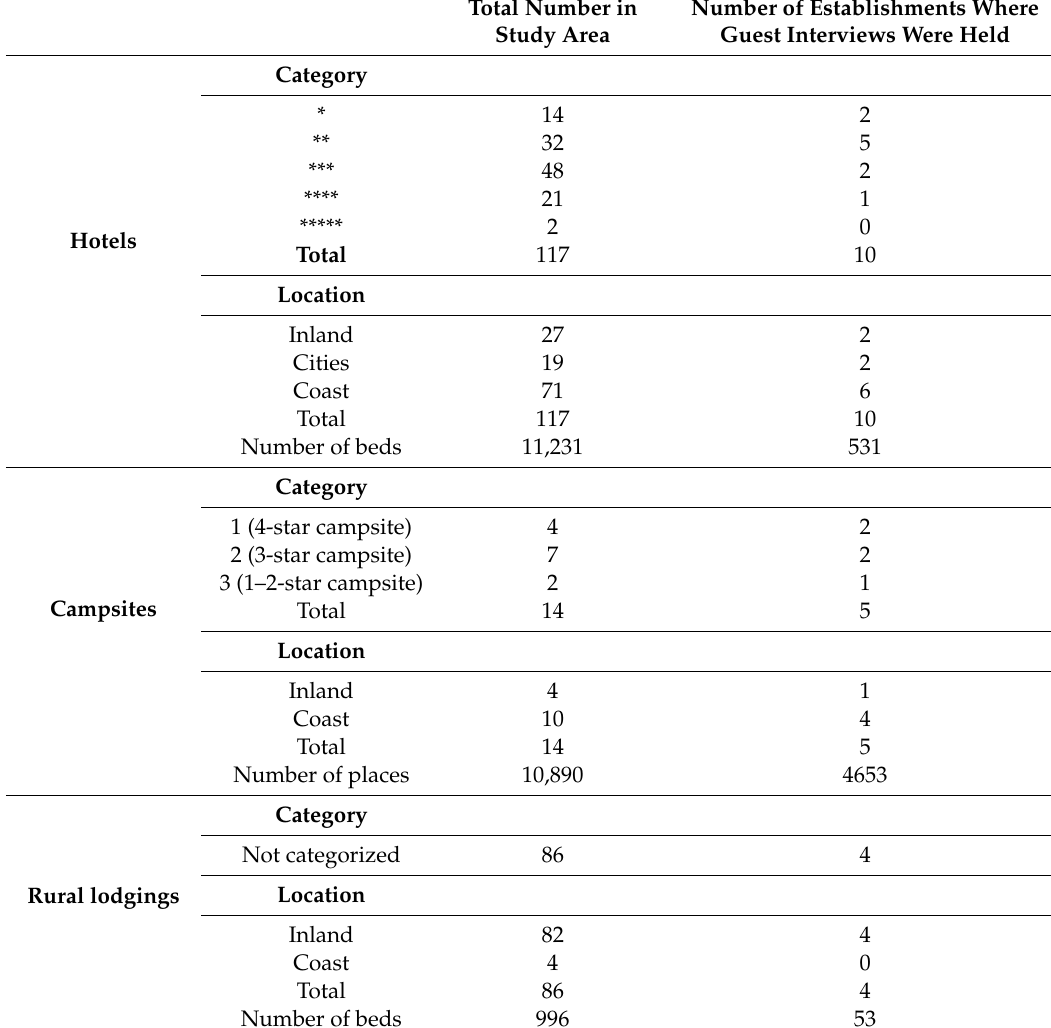
Table 1. Main characteristics of tourist accommodation establishments where guests were